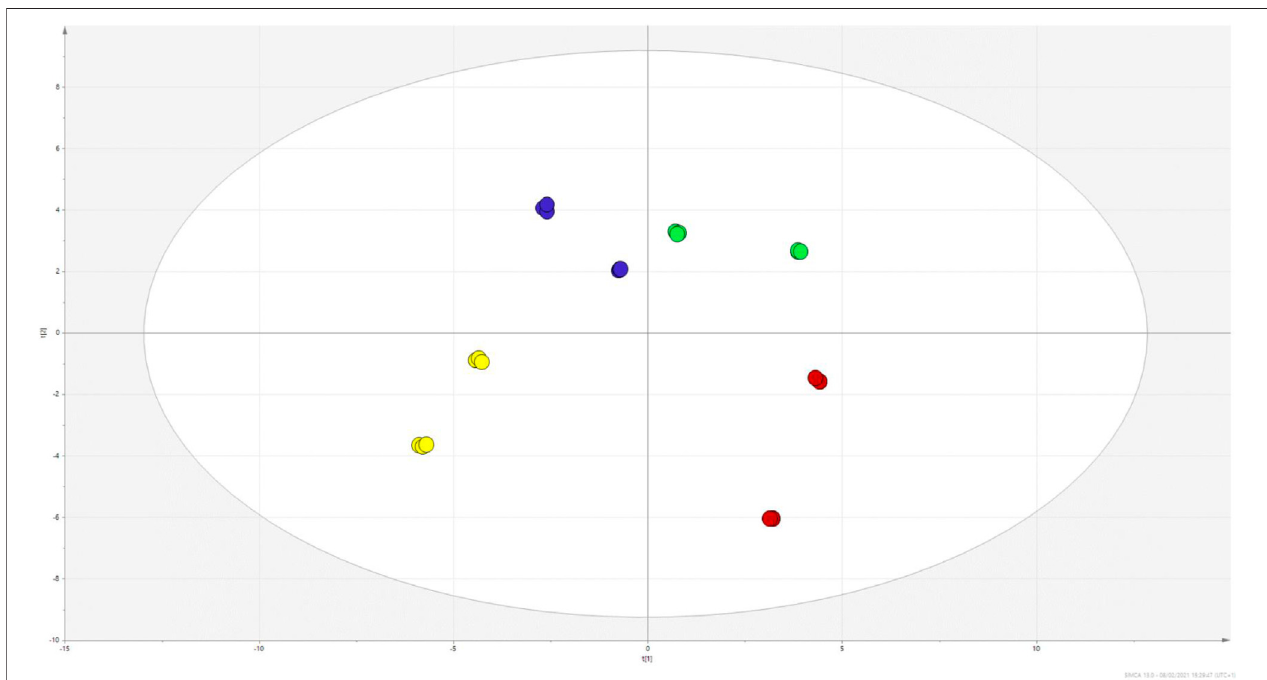
FIGURE 4 | PCA scatter plot obtained from the quantitative data of H. triquetifolium aerial and roots extracts (red and yellow dots, respectively) and H. neurocalicinum aerial and roots extracts (green and blue dots, respectively).